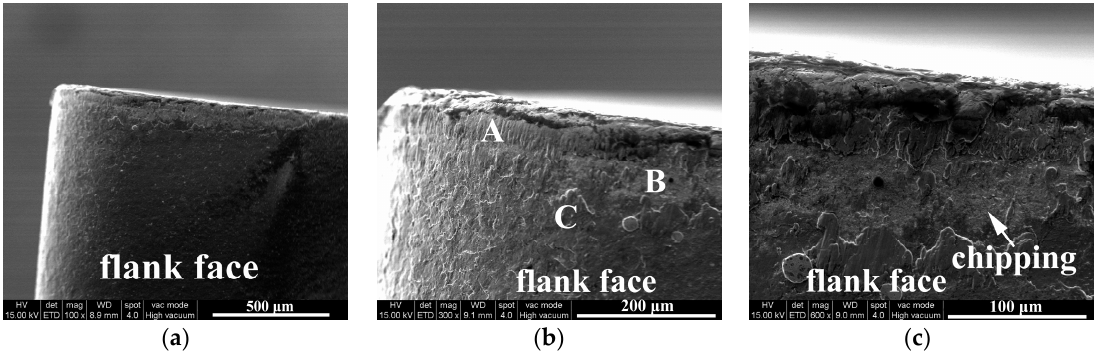
Figure 4. SEM images of flank face of the TiAlN-coated insert after machining for 6 min (cutting speed of 40 m/min, feed rate of 0.1 mm/r, depth of cut of 1.0 mm): ( a ) flank face; ( b ) flank face close to nose; and ( c ) magnification of Figure 4b.